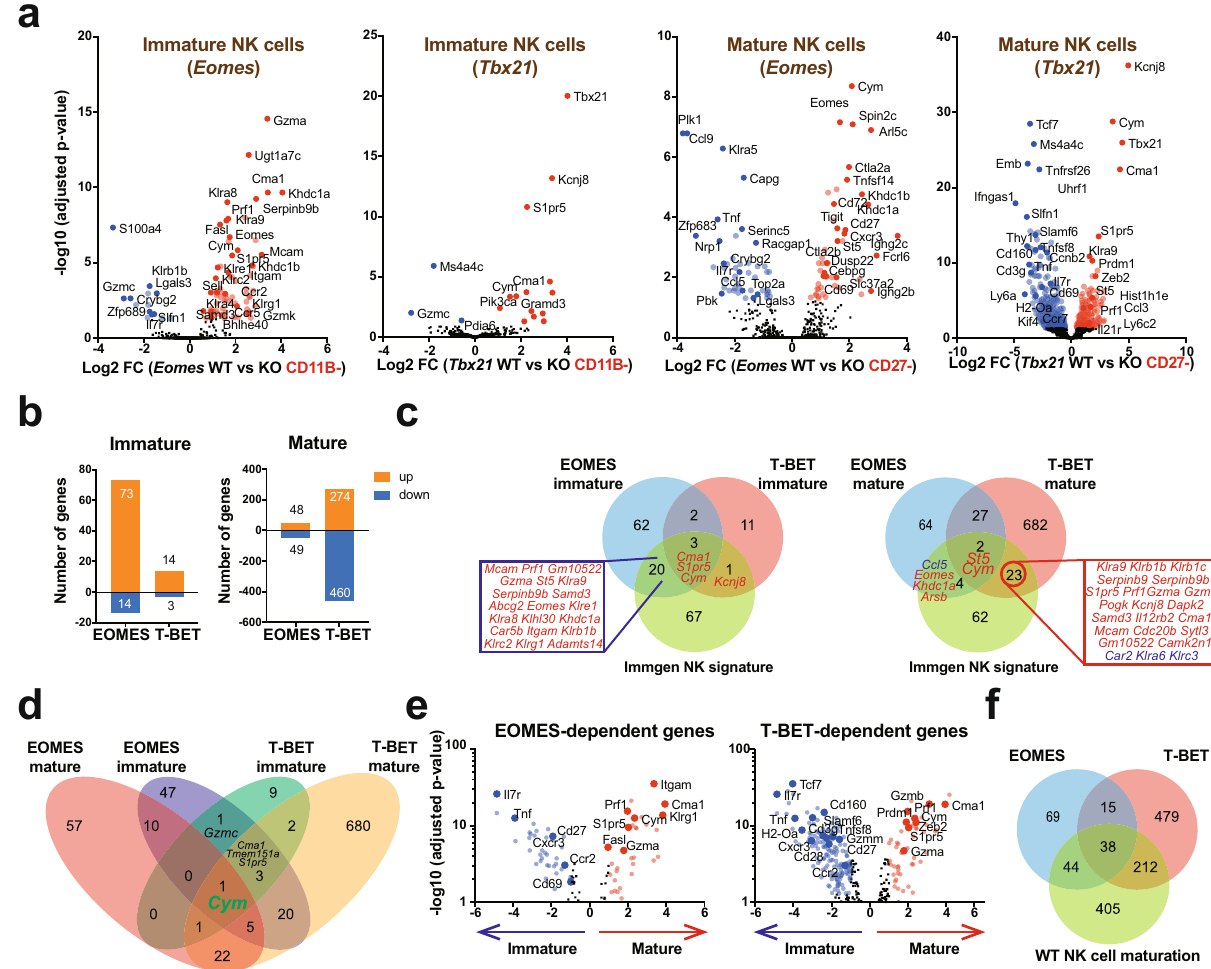
Fig. 4 EOMES and T-BET have mostly distinct roles on NK cell transcription during maturation. RNA-seq analysis of sorted Tbx21 − / − , Eomes − / − and appropriate control CD11B- and CD27 − NK cells ( n = 3 per group with three sorts in total). DEG were selected based on adjusted p < 0.05 (as determined by use of negative binomial generalized linear models). a Volcano plots of gene expression in immature CD11B- or mature CD27 − NK cells comparing T-BET or EOMES de fi cient cells with appropriate controls. Selected genes are highlighted with their names. b Bar histograms showing the number of genes induced or repressed by T-BET or EOMES in immature and mature NK cells. c Venn diagram showing the overlap between the Immgen-de fi ned NK cell signature and the EOMES-activated and T-BET-activated genes in immature and mature NK cells. d Venn diagram showing the overlap between T-BET regulated and EOMES-regulated genes in immature and mature NK cells. e Volcano plots comparing the expression of T-BET or EOMES dependent genes between WT immature and mature NK cells. Selected genes are highlighted with their names. DEG were selected based on adjusted p < 0.05 (as determined by use of negative binomial generalized linear models). f Venn diagram showing the overlap between T-BET-dependent, EOMES-dependent and maturation-regulated